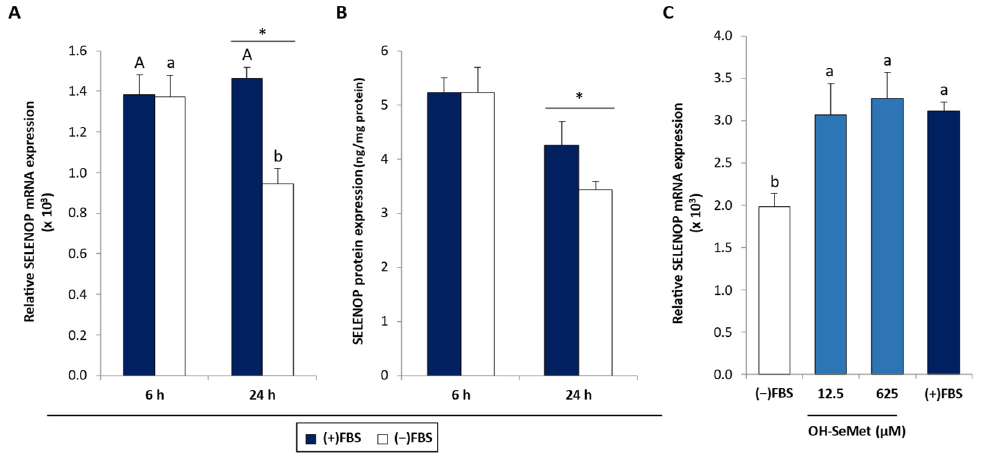
Figure 2. ( A ) GPX1 relative gene expression and ( B ) GPX activity in macrophages cultured in (+)FBS or ( − )FBS for 6 or 24 h and ( C ) GPX1 relative gene expression in macrophages maintained for 24 h in ( − )FBS or in (+)FBS and supplemented with 12.5 and 625 μ M OH-SeMet for an additional 72 h. Gene expression results were calculated using 2 −Δ Ct . The results are expressed as mean ± SEM of n = 6 cultures. The asterisk (*) denotes significant differences ( p < 0.05) between (+)FBS and ( − )FBS ( A , B ), and different letters denote differences ( p < 0.05) between incubation periods ( A ) and conditions ( C ).